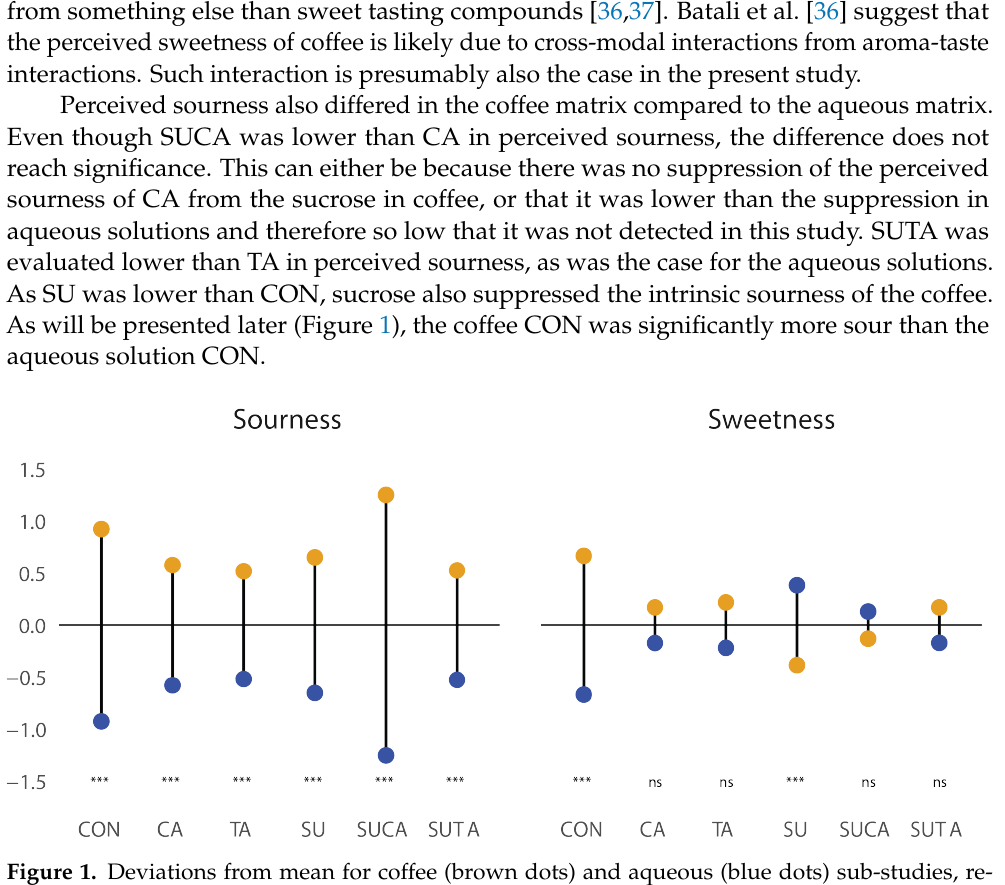
Figure 1. Deviations from mean for coffee (brown dots) and aqueous (blue dots) sub-studies, re- spectively. Significance: ns = not significant, *** < 0.001. Samples are Control (CON), Citric Acid (CA), Tartaric Acid (TA), Sucrose (SU), Sucrose, and Citric Acid (SUCA), and Sucrose and Tartaric Acid